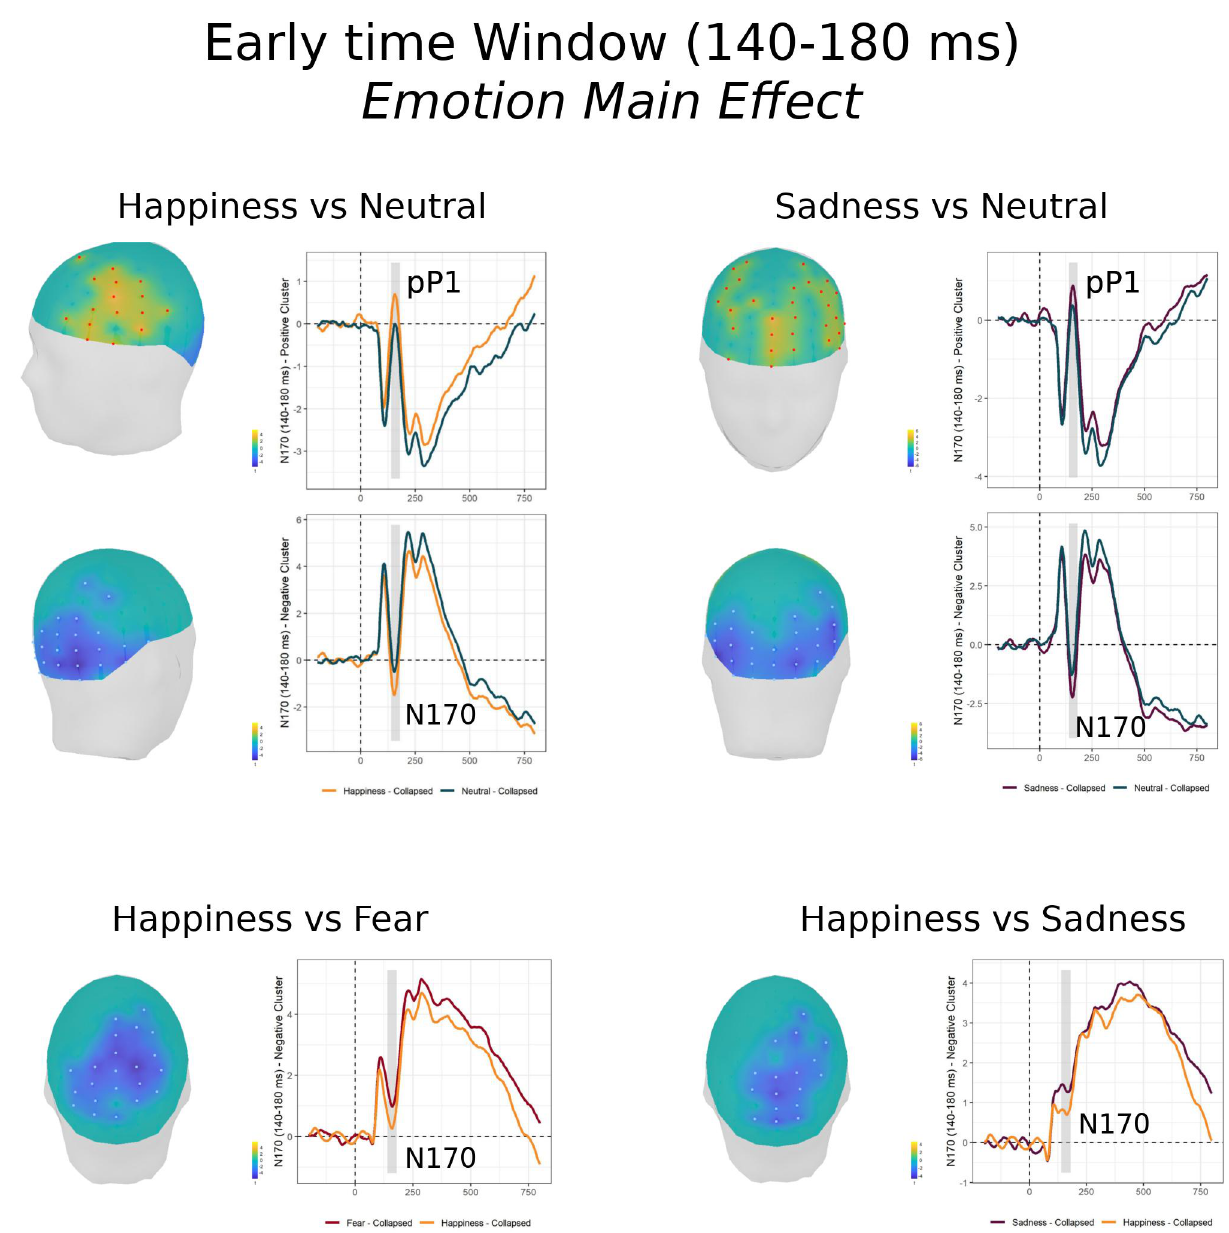
Figure 2. Early time window (140–180 ms): Emotion Main effect: On the right of each panel, grand-average waveforms of the electrodes included in the significant positive and negative clusters; on the left of each panel, the scalp topography of the significant clusters (the sensors included are highlighted in red for the positive clusters and in white for the negative clusters). Left panel: Happiness vs. Neutral; middle panel: Sadness vs. Neutral; right panel: A—Happiness vs. Fear; B—Happiness vs. Sadness. Emotions are collapsed across